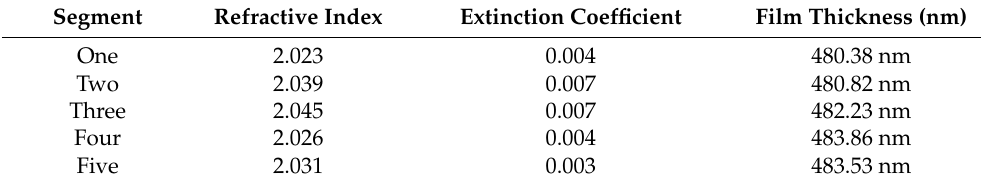
Figure 8. Transmission spectra of Ta 2 O 5 thin film deposited on different segments. Table 2. Optical constants of Ta 2 O 5 thin film for different segments.